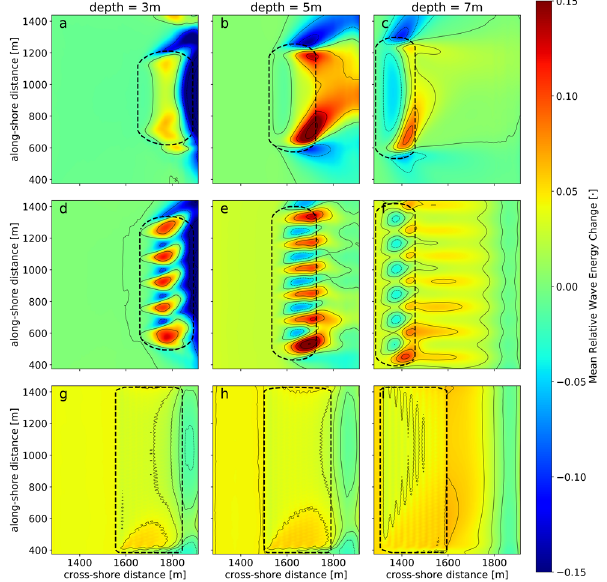
Figure 8. Mean wave energy attenuation averaged over the first two months of the South Padre Island scenario simulations. ( a – c ) LB at 3 m, 5 m, and 7 m depths, respectively. ( d – f ) UB at 3 m, 5 m, and 7 m depths, respectively. ( g – i ) DM at 3 m, 5 m, and 7 m depths, respectively. Dashed black lines indicate convex hull of nourishments initial footprint.